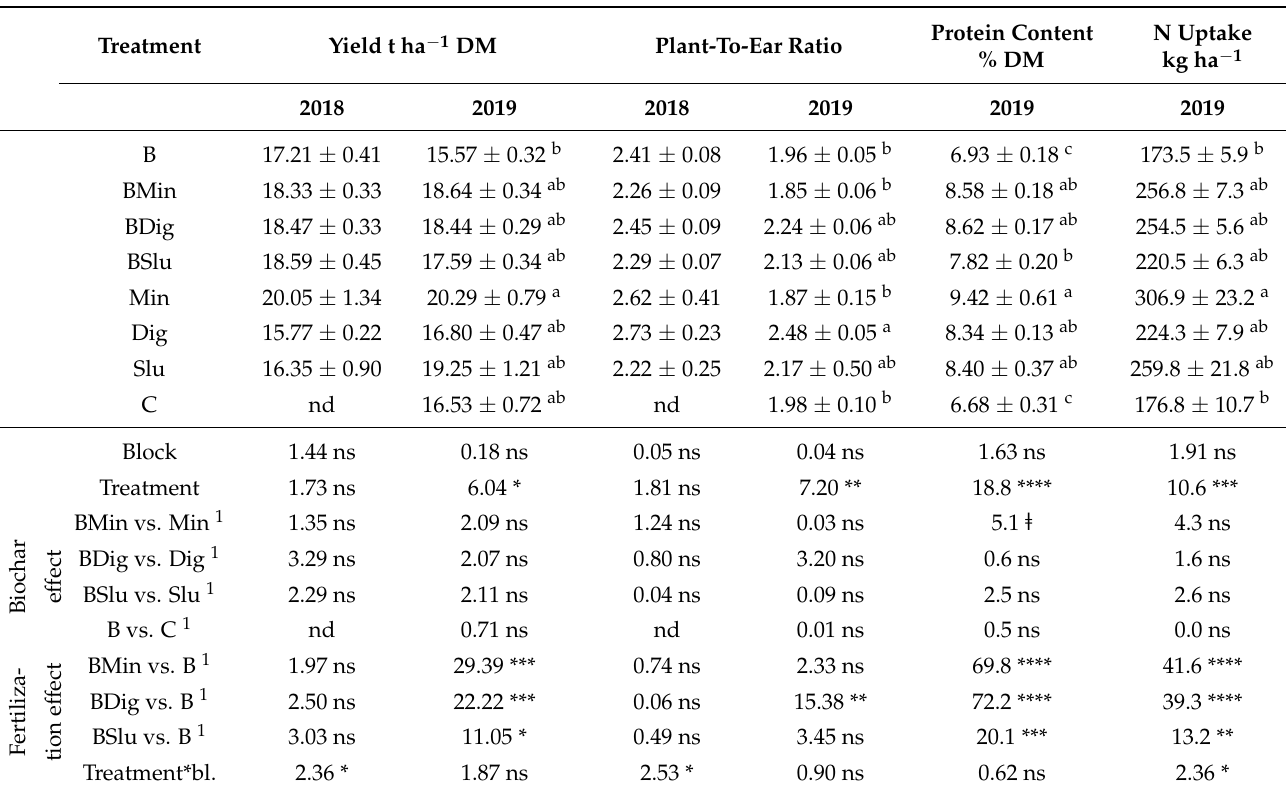
Table 3. Silage maize yield and components of the production (plant-to-ear ratio) in the two years, 2018 and 2019; silage maize protein content and N uptake in 2019; mean values and SE; analysis of variance (ANOVA)